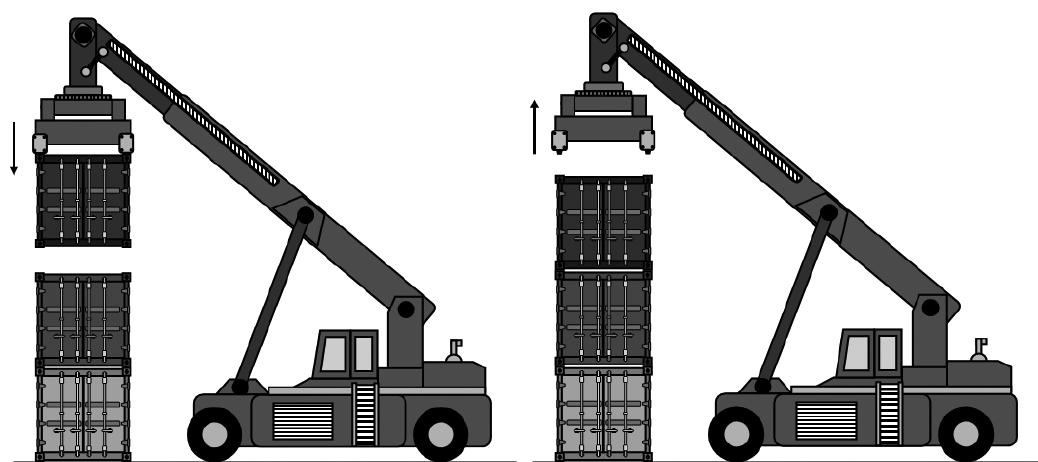
Figure 4. Operation No. 4—setting aside a large type A container on a third layer stack, within a prescribed sector of a storage yard. Source: own work.